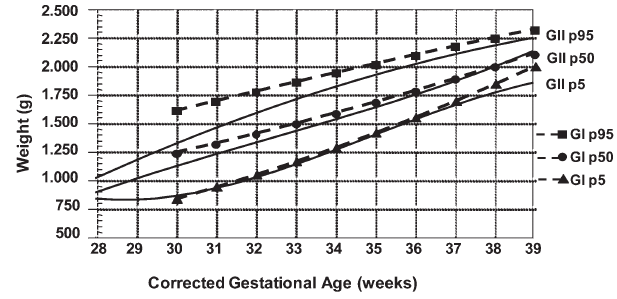
Figure 1 - Estimated values of 5 th , 50 th and 95 th percentiles of GI and GII VLBWIs (in g).